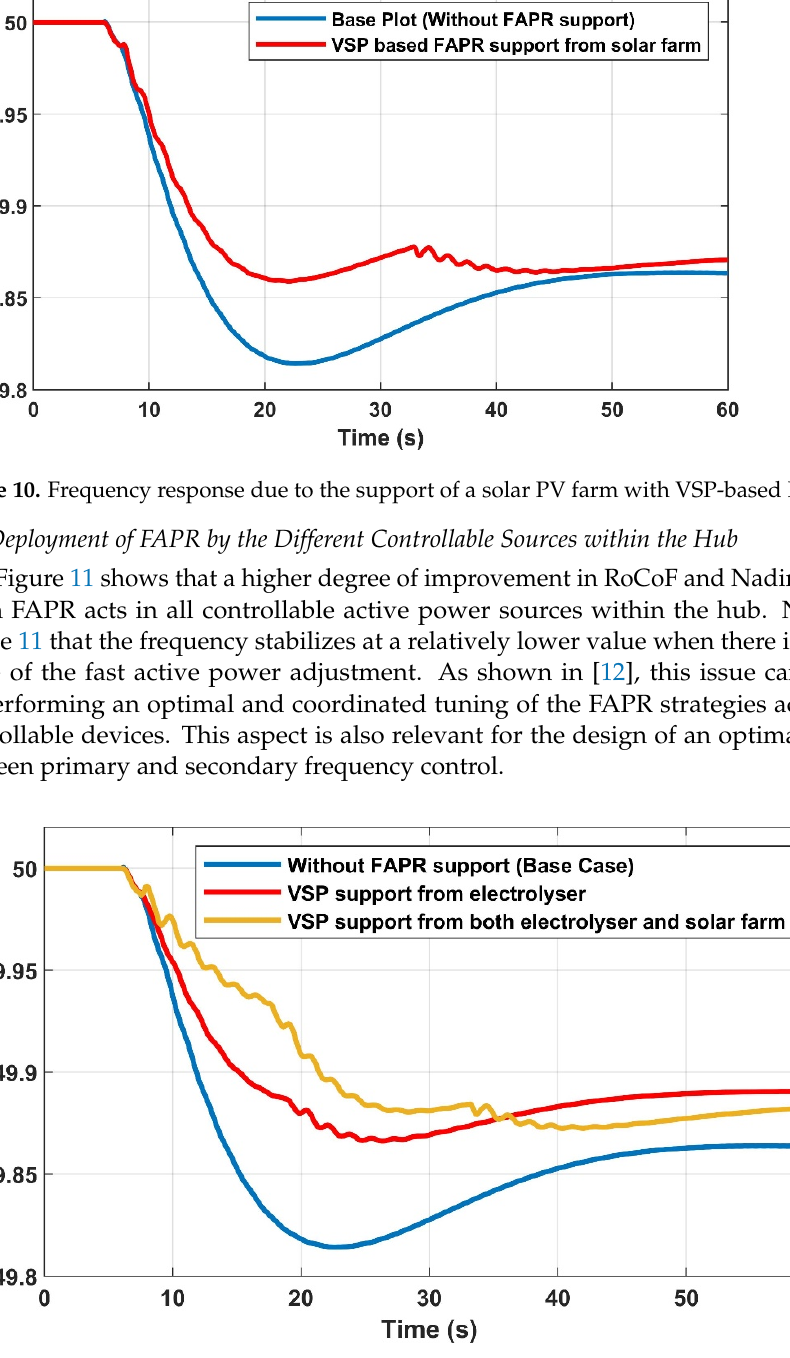
Figure 9. Shape of the system frequency response due to the action of FAPR on the PEM electrolyzer.